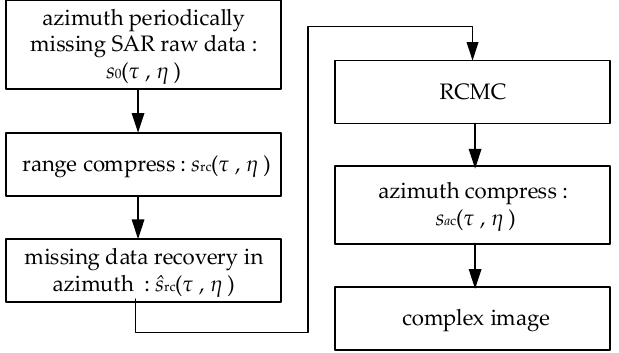
Figure 4. Flowchart of the proposed imaging method.